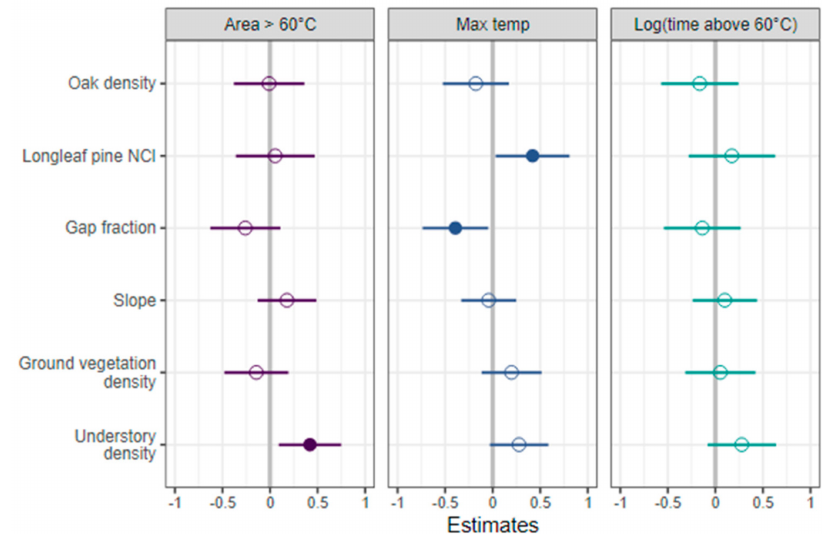
Figure 2. Coefficients from linear models estimating fire temperature metrics: area under the integrated curve for temperatures above 60 ◦ C ( left ), maximum temperature ( center ), and time above 60 ◦ C (log transformed; right ). Filled circles indicate significant parameter estimates ( p <